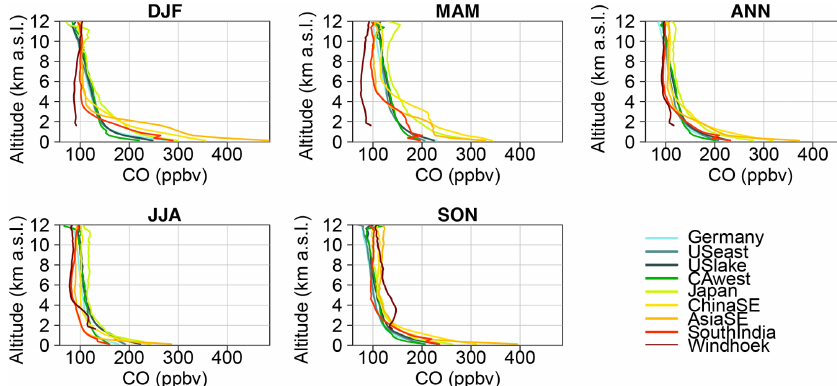
Figure 5. Mean seasonal profiles of CO mixing ratios at the different clusters.